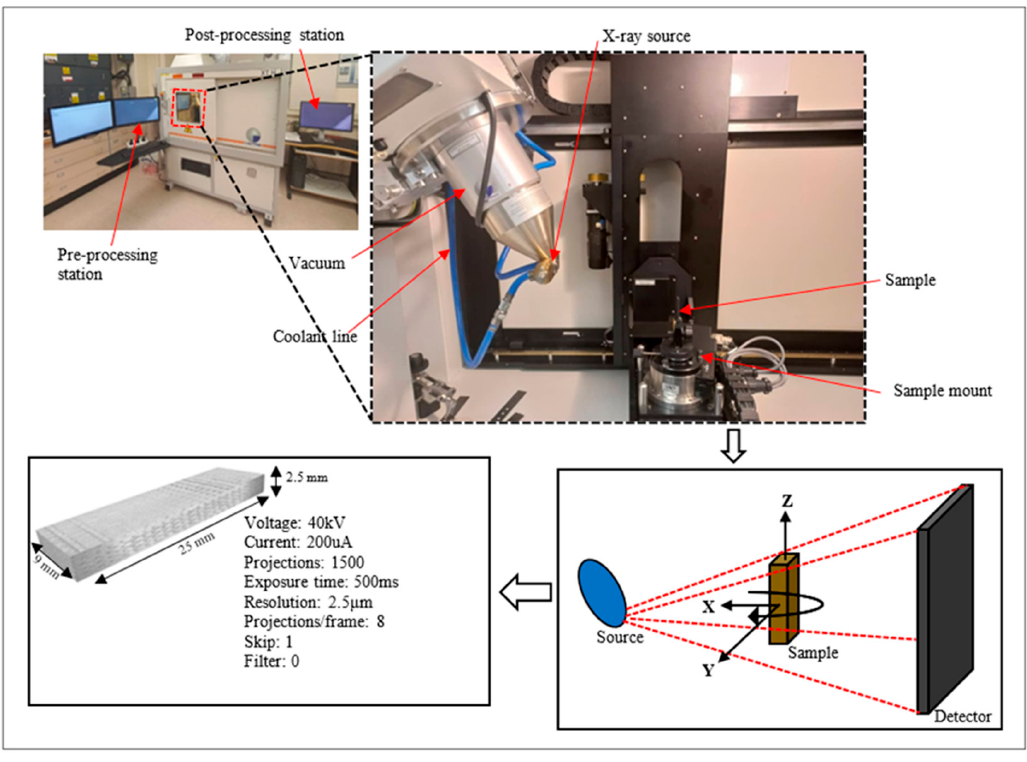
Figure 3. X-ray micro-CT setup and detailed scanning parameters .